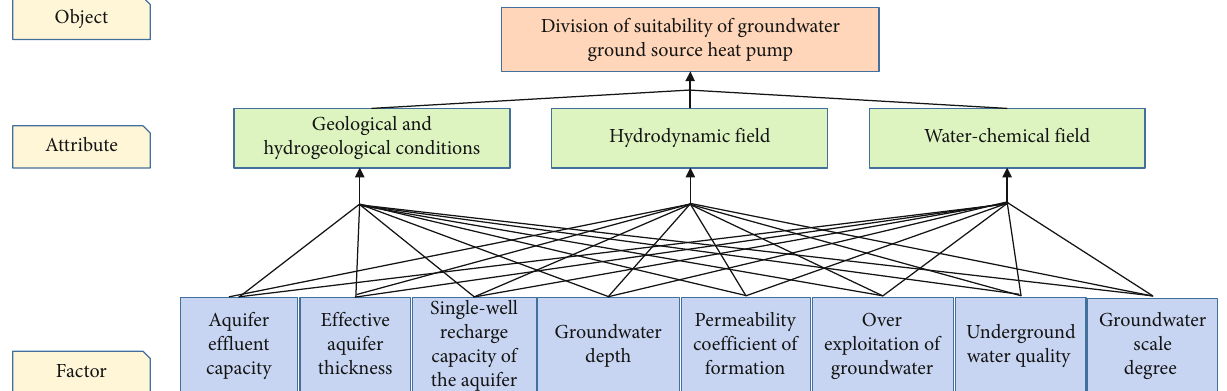
Figure 7: Structural diagram of the hierarchical analysis method of the underground water ground source heat pump.